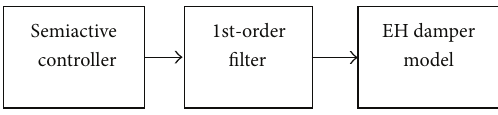
Figure 5: Dynamic transient behavior